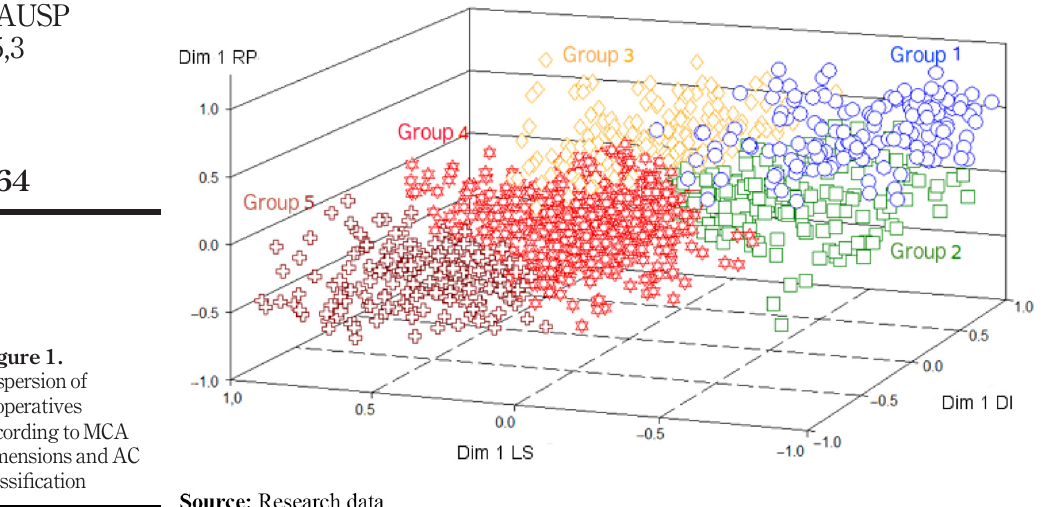
Figure 1. Dispersion of cooperatives according to MCA dimensions and AC classi fi